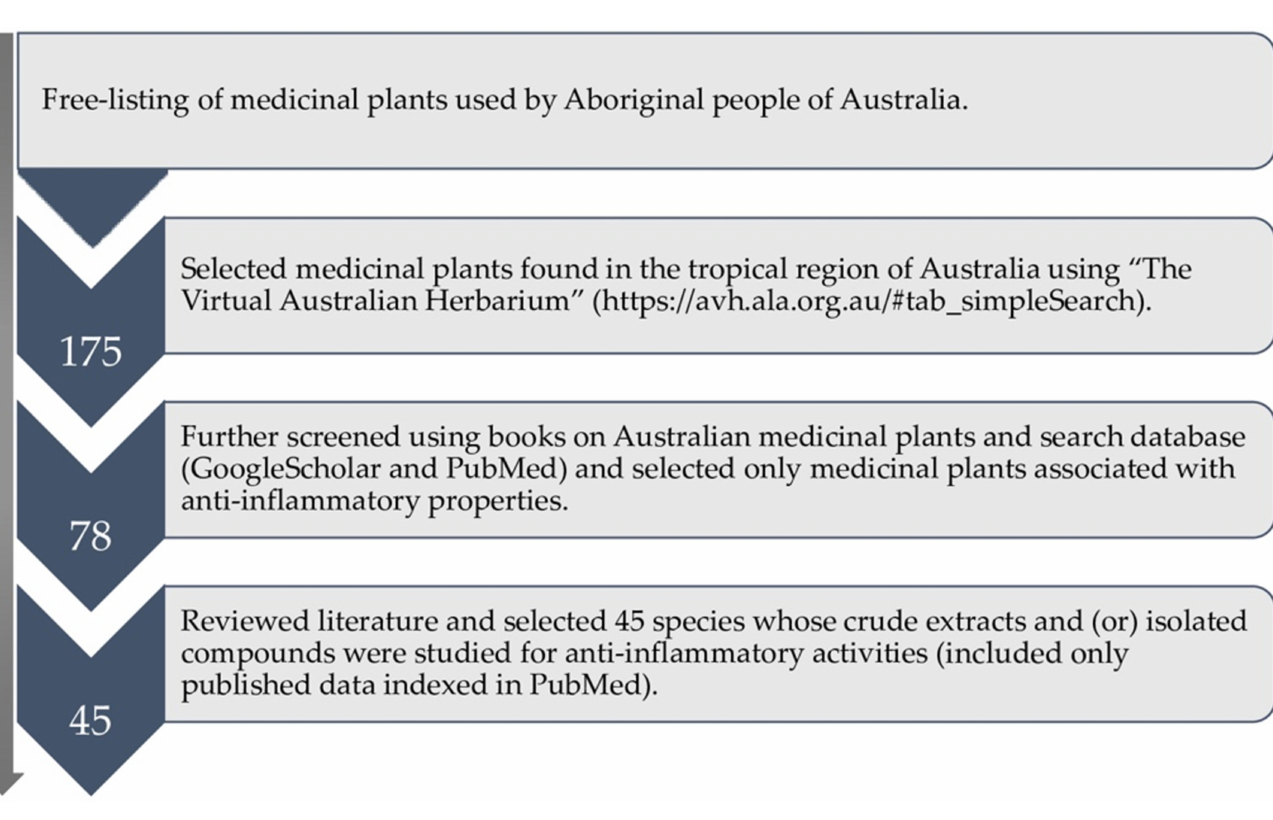
Figure 2. Number of anti-inflammatory medicinal plant species of tropical Australia selected against each criterion for their phytochemical and pharmacological properties review.